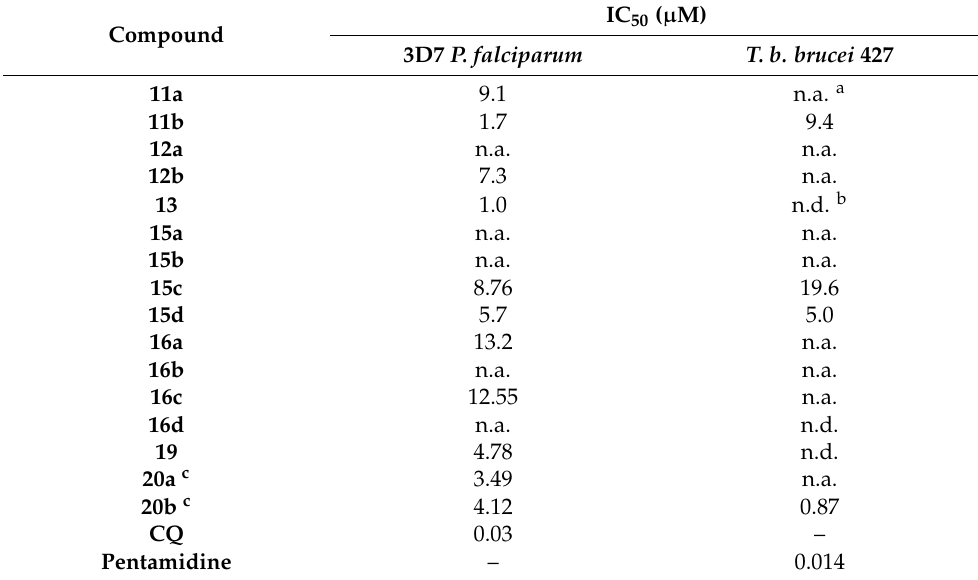
Table 1. Antiplasmodial and antitrypanosomal activities of target compounds against 3D7 P.